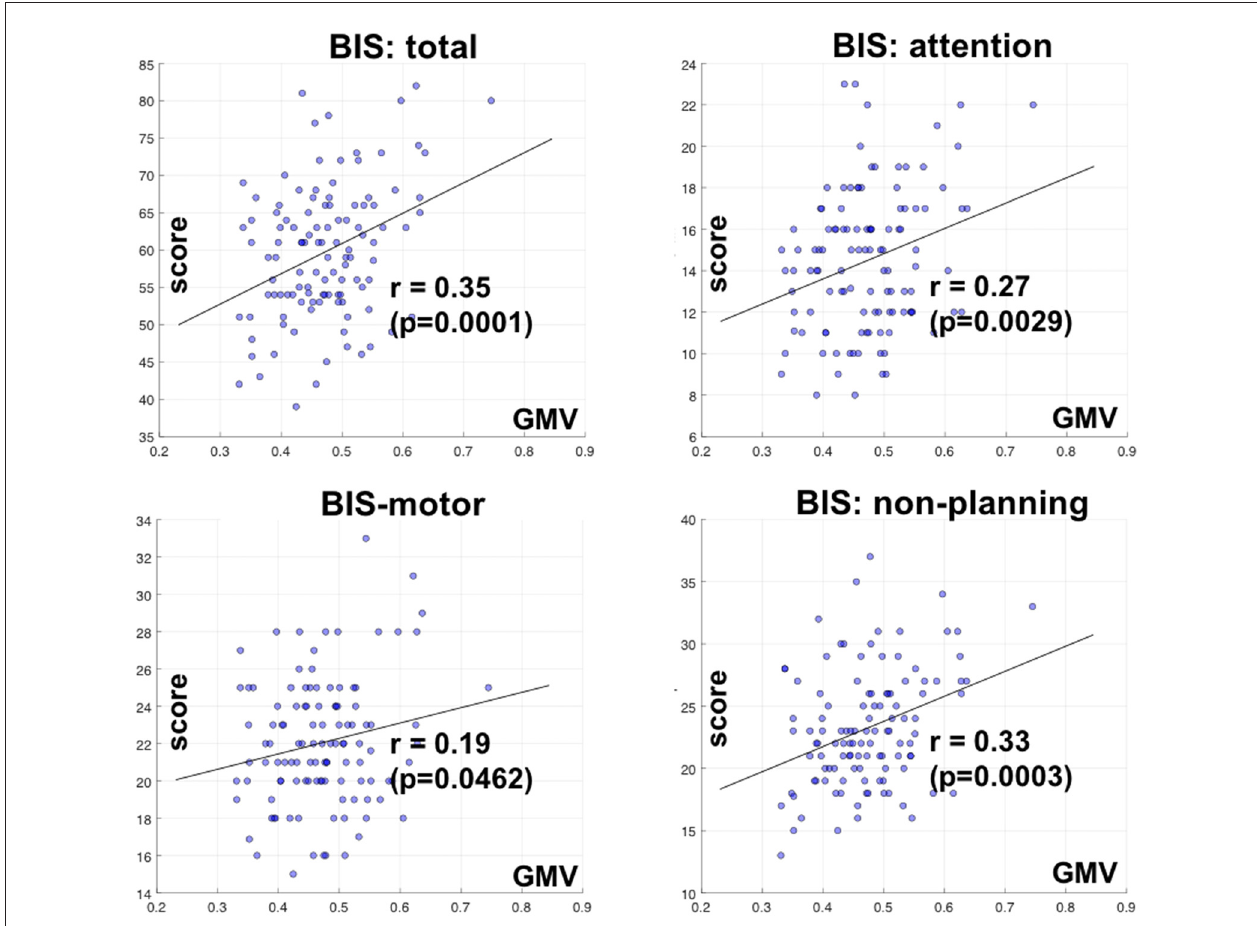
FIGURE 3 | Correlation of GMV of the cluster identified in bilateral parietal occipital cortex with Barratt impulsivity total and subscores. R and P values are shown for Pearson regression. Each circle represents the data of one